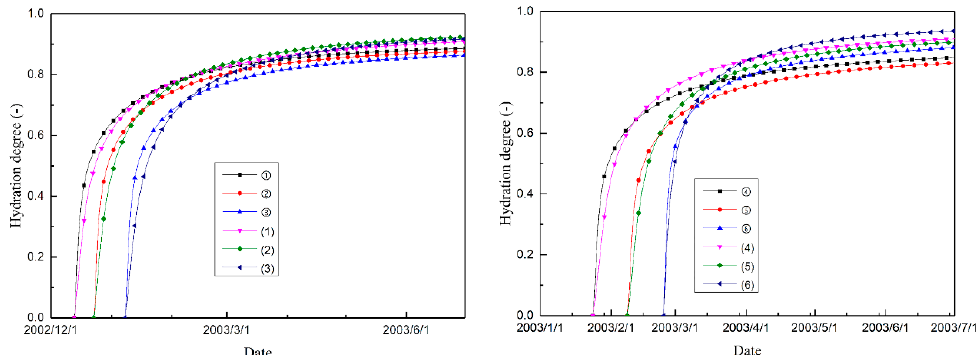
Figure 9. Cement hydration degree histories of different typical points.